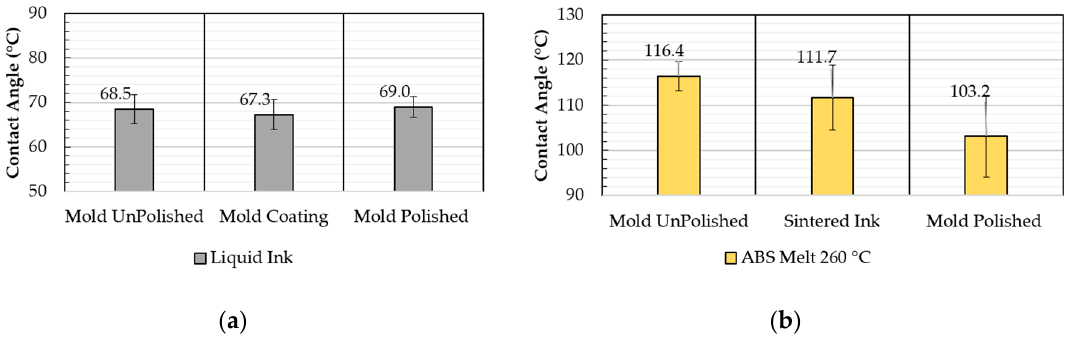
Figure 8. Contact angle measurements using ( a ) liquid ink and ( b ) ABS melt at 260 °C on different surfaces.